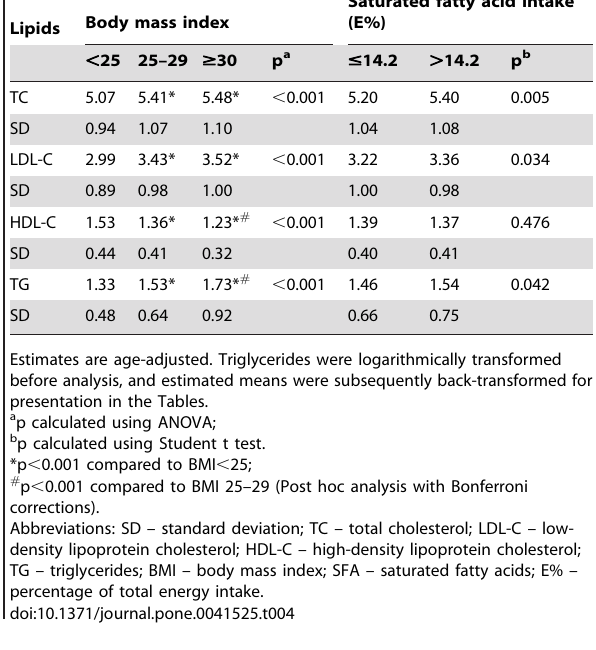
Table 2. Characteristics of the population (means and standard deviations (SD) or percentage) according to apolipoprotein E genotype (men).